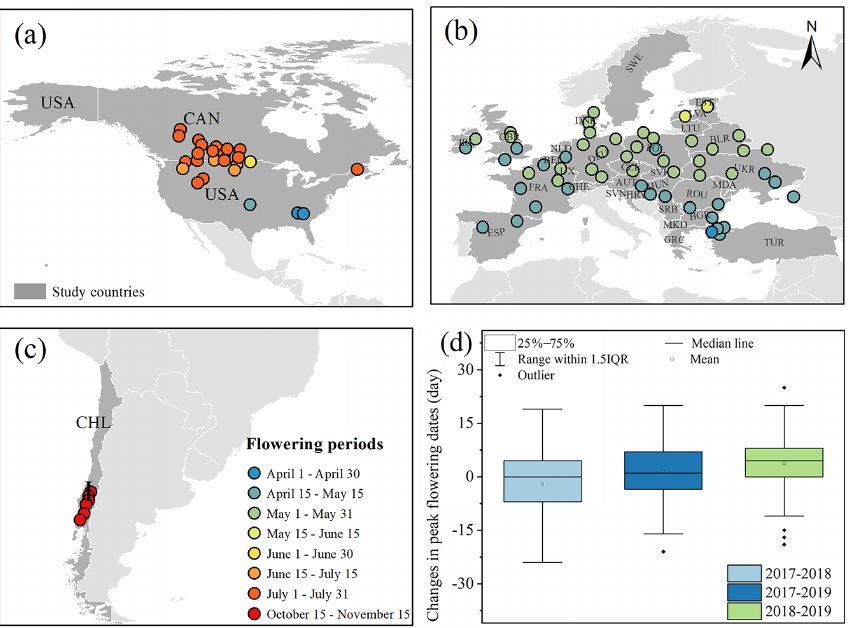
Figure 4. Flowering phenology of rapeseed. (a) – (c) The spatial distribution of rapeseed flowering periods among sample blocks. (d) Boxplot showing changes in peak flowering dates of sample blocks over 3